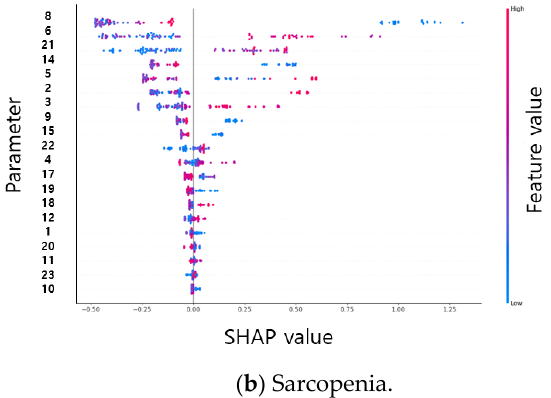
( b ) Sarcopenia. Figure 4. SHAP plots of the spatial–temporal parameters of osteopenia ( a ) and sarcopenia ( b ). The parameter with the highest SHAP value within the descriptive statistical param- eters of osteopenia is the skewness of the x -axis of the accelerometer in the initial swing phase (parameter number 247). Initial swing refers to the FA after TO. When the skewness is negative, the probability density function has a long tail on the left side, and the data, including the median, are more distributed on the right side. When the skewness is positive, there is a long tail on the right side of the probability density function, indicating that the data are more distributed on the left side. Skewness has a positive value when the mean is smaller than the median, negative when the mean is larger, and has a larger value as the difference between the median and the mean becomes larger. When there is a negative value, the right part of Figure 5a has a long tail, but the average decreases and the skewness value becomes small or negative.